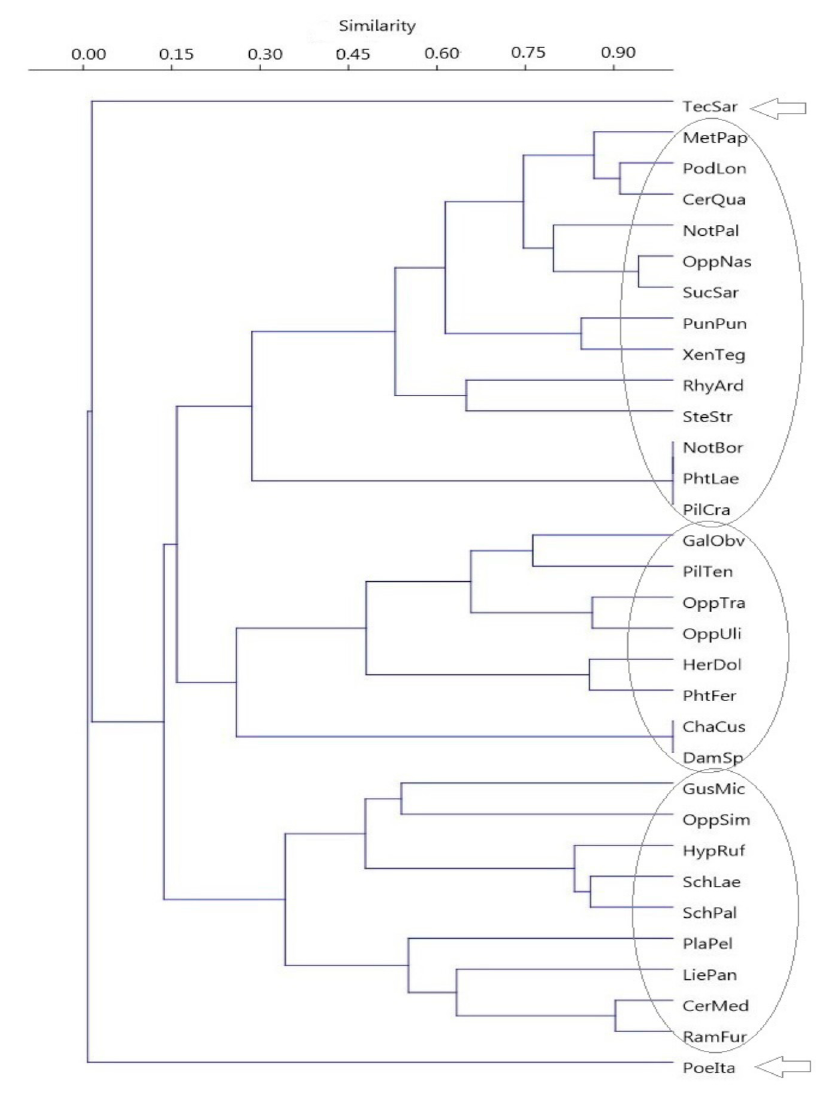
Figure 3. Dendrogram resulting from a clustering procedure using the Bray–Curtis method and showing the similarities of the oribatid mite community at the study’s four sites.